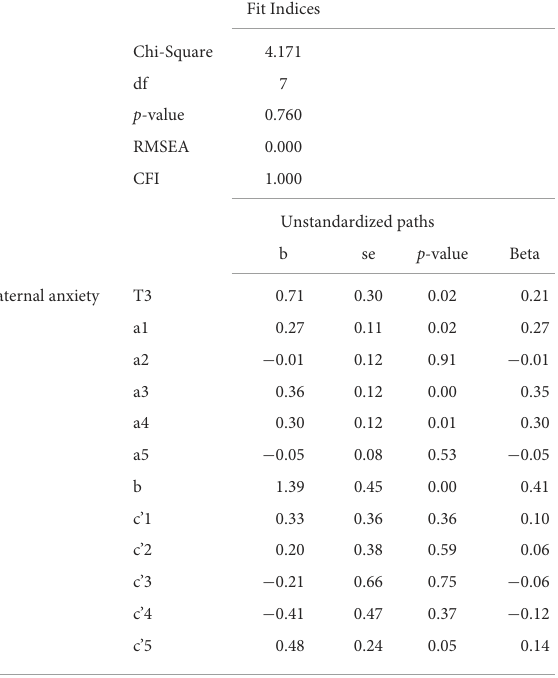
TABLE 4 Results of the mediation model (links a, b and c’). Fit Indices